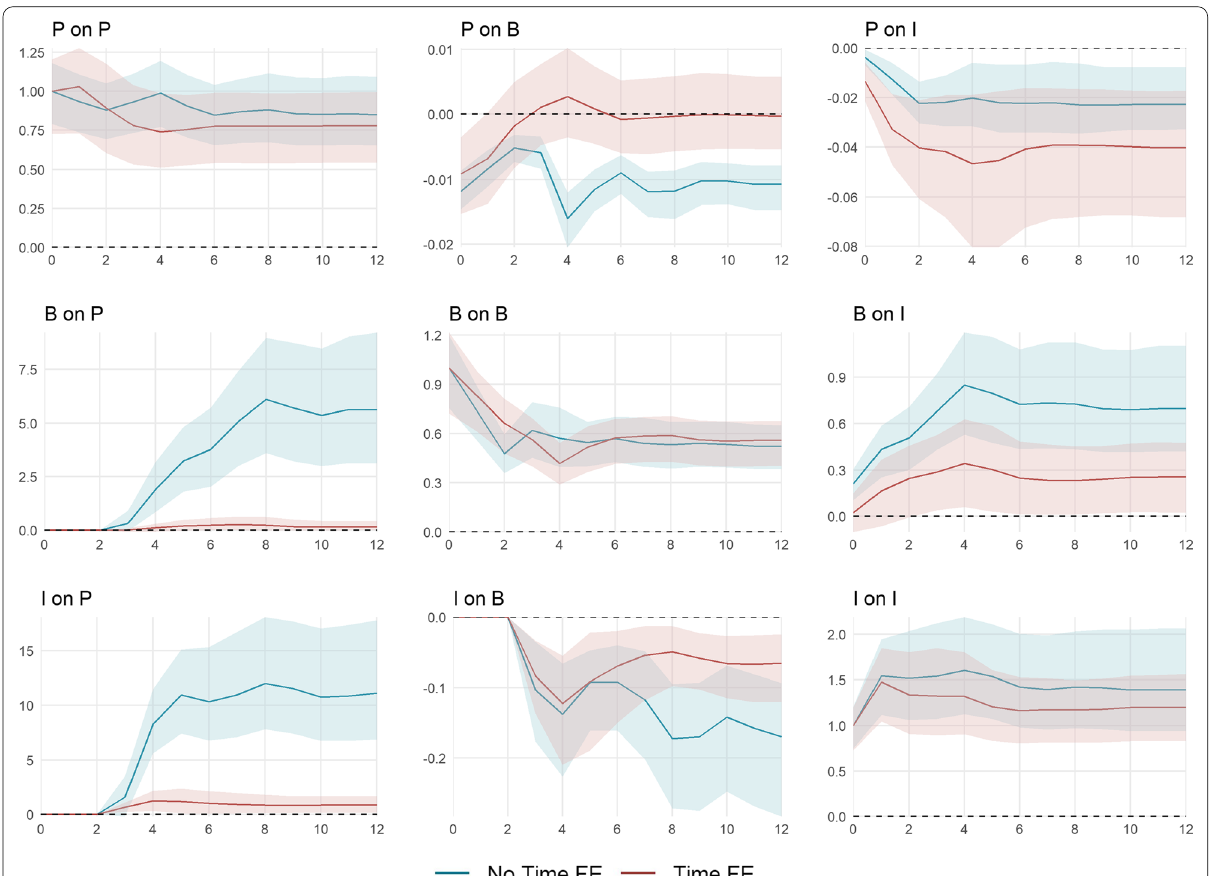
Fig. 7 Cumulative impulse responses of policy P , behavior (consumption) B , and infection growth I . The impulse responses are estimated using the ln R e with (red) and without (blue) time fixed effects. The data 3 and P (cid:31) KSI + , B (cid:31) lnNTRX , and I recursively ordered VAR(4) in (4) with k = = = = spans September 28, 2020, until April 18, 2021. The shaded areas represent the 95% confidence intervals based on a wild bootstrap procedure with 5000 repetitions. The horizontal axes depict the time horizon in weeks. The vertical axes show the level response of the KSI + (left), lnNTRX (middle), lnNINF